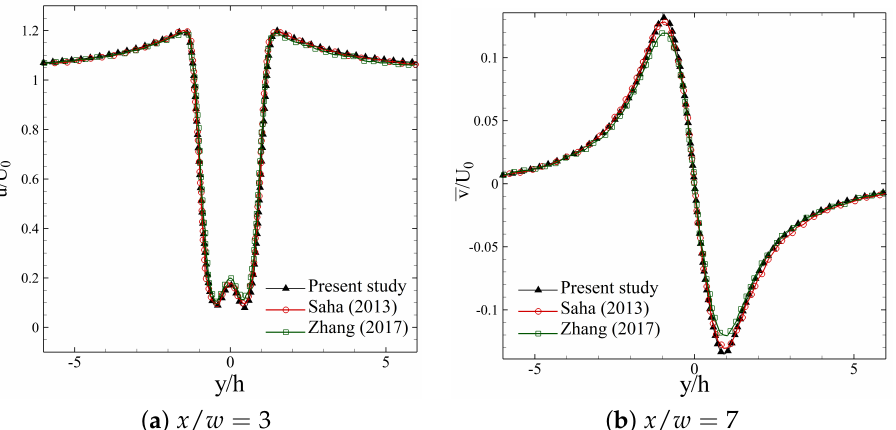
Figure 6. Time-averaged ( a ) streamwise and ( b ) spanwise velocity distributions at Re = 250 behind a rectangular prism with AR = 4 at z / w = 3.5 compared with DNS results of Saha (2013) [15] and Zhang et al. (2017)